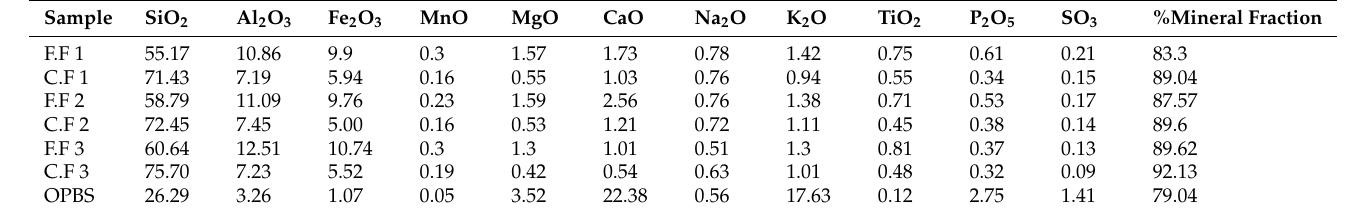
Table 4. Chemical composition of the three soil samples and Olive Pomace Biomass Slag